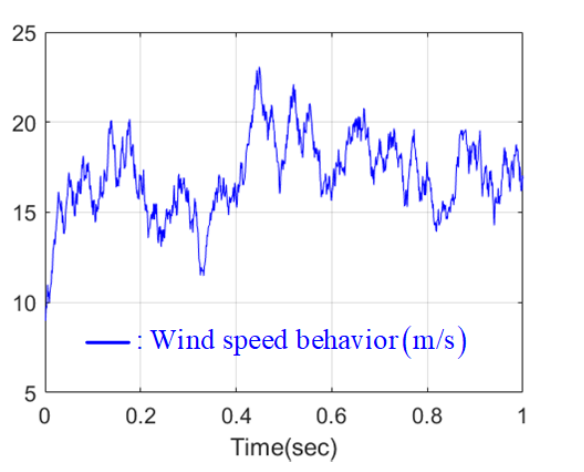
Figure 2. Wind speed pattern from Weibull distribution-based wind